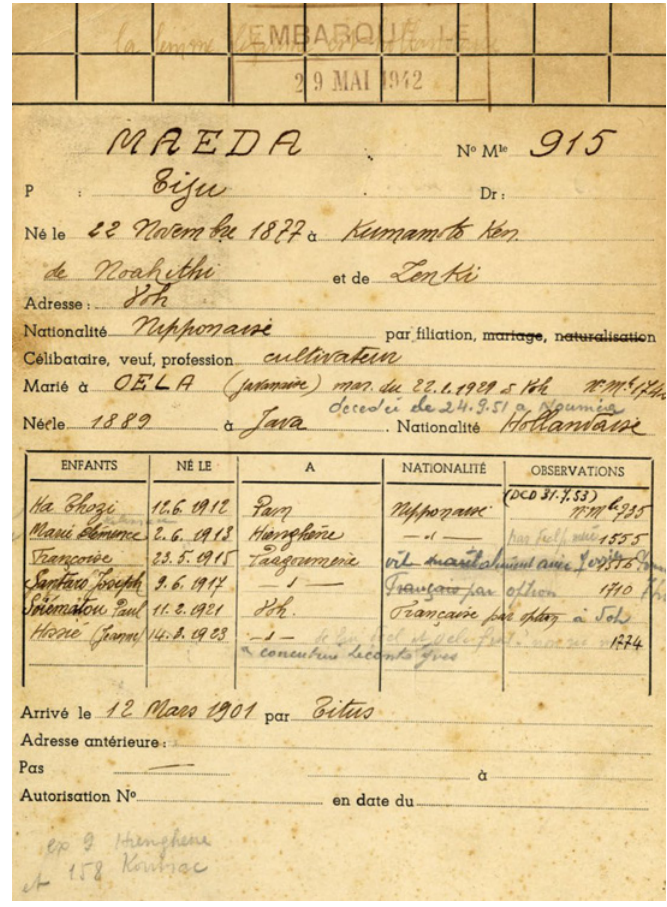
Figure 3 Identity card of Tiju Maeda, deported in May 1942. Under the column for nationality, Maeda’s children can be seen maintaining differing nationalities. Those who are French are designated par option , meaning that they opted for French citizenship at the age of eighteen and renounced their Japanese citizenship © Archives de la Nouvelle-Calédonie. Used with